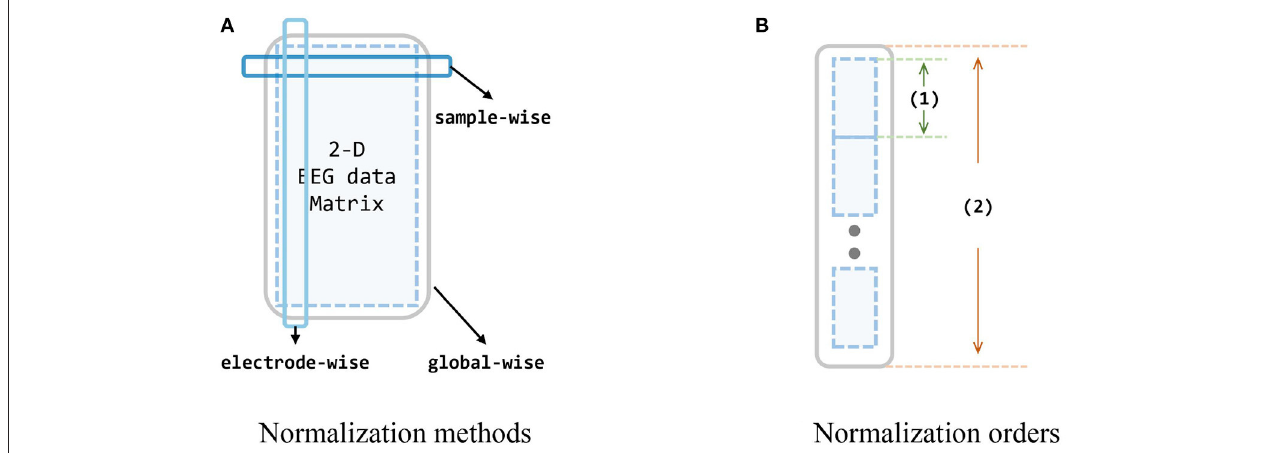
FIGURE 5 | Evaluation of normalization methods and orders. (A) The dark blue box stands for the sample-wise normalization, while the light blue box stands for the electrode-wise normalization. The big gray box stands for the global-wise normalization. (B) There are two normalization orders (involving two operations for single source and all sources): concatenate all sources first, and normalize global-wise, or normalize every single source first, and concatenate them all. Small blue matrices are data from different subjects, (1) is an operation for one single source, and (2) is an operation for all sources. In order A, (1) in the figure stands for the normalization, and (2) stands for the concatenate (i.e., normalize every single source first, and then concatenate them all). In order B: (1) stands for concatenating while (2) is for normalization (i.e., concatenate every single source into one big source domain first, and then normalize this domain).